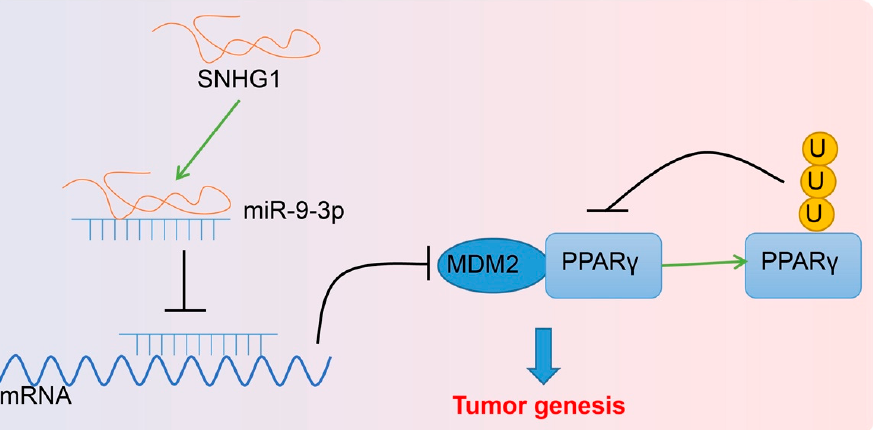
Figure 9. Flow map. SNHG1 promotes MDM2 expression by binding to miR-9-3p to promote PPAR γ ubiquitination and downregulate PPAR γ expression, thereby resulting in elevation of bladder cancer cell proliferation in vitro and tumorigenesis in vivo.